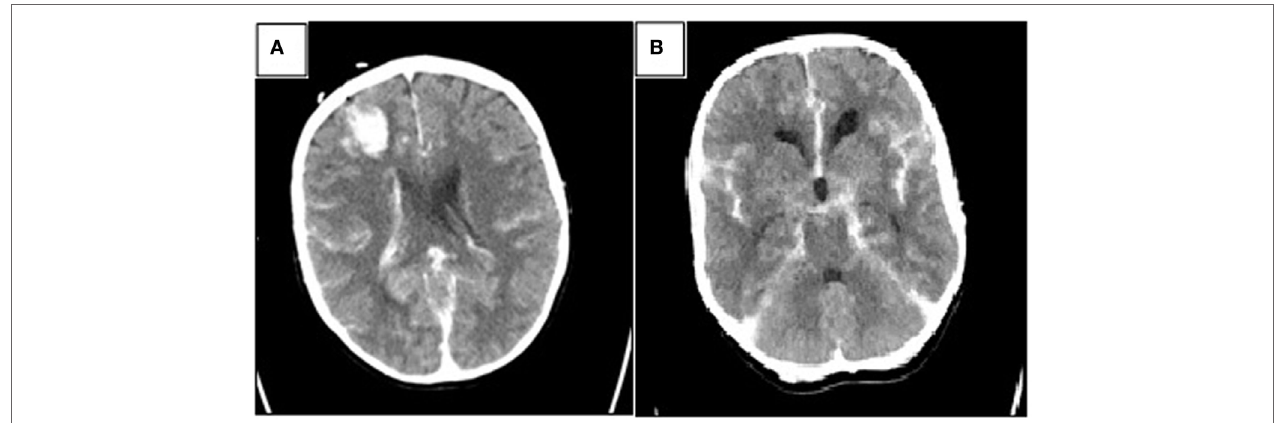
FIgURe 2 | Postoperative head computed tomography (CT) showing (a) small amount of hemorrhage along the choroid plexus with a small hematoma in the frontal right lobe corresponding with the ventricular shunt tap and (B) basal cisterns with hemorrhage (Fisher